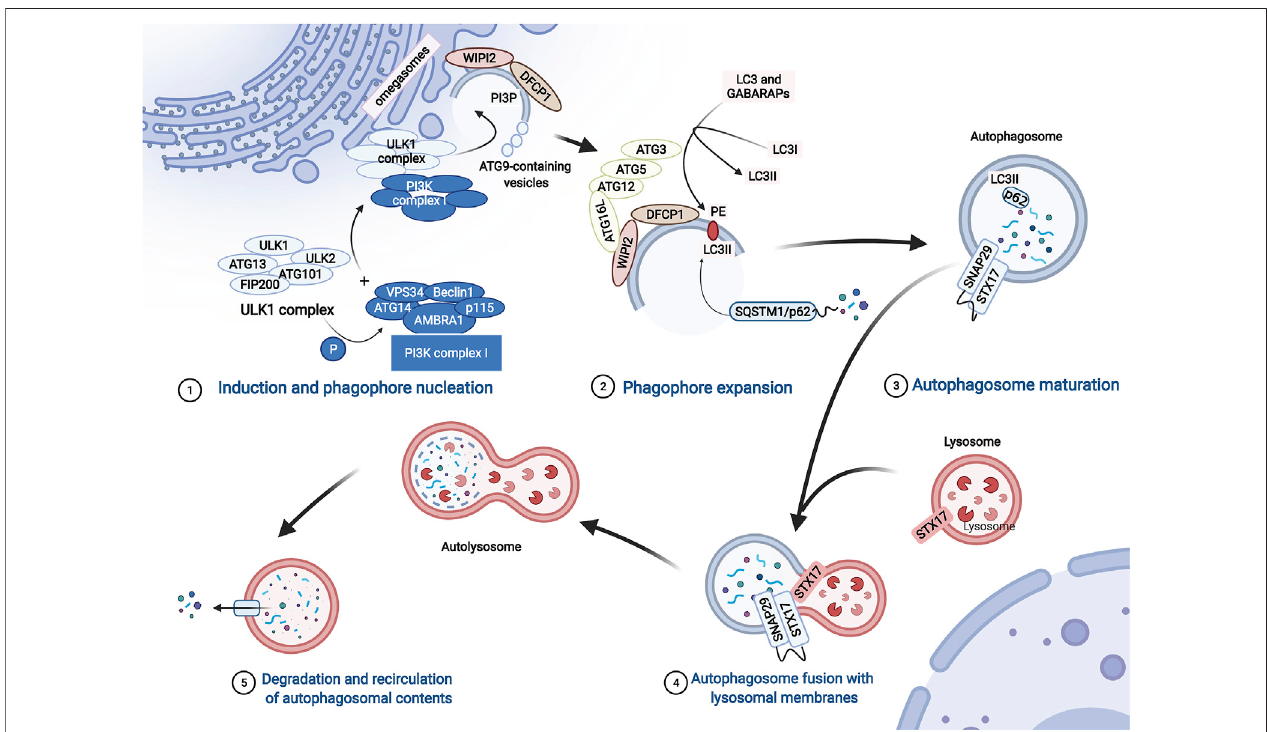
FIGURE 2 | The process of autophagy. The process of autophagy includes induction and phagophore nucleation, phagophore expansion, autophagosome maturation, autophagosome fusion with lysosomal membranes, degradation, and recirculation of autophagosomal contents. Induction and phagophore nucleation occurinthestructureknownasthe “ omegasome ” ontheendoplasmicreticulummembraneandaremainlymediatedbytheULK1complexandPI3KC3complexI.Local activated PI3P and recruited Atg9 provide the raw materials required for membrane formation. Then, the ATG12-ATG5-ATG16L1 complex is recruited to the membraneofthephagophore, enhancing theconversionofLC3andGABARAPs tomembrane-resident PE,promotingphagophoreexpansion.Duringtheformationof autophagosomes, p62 serves as a bridge connecting LC3 with the ubiquitinated substrate. Finally, the ATG12-ATG5 and ATG8/LC3 conjugation systems mediate the process by which the isolation membrane of the autophagosome forms a closed bilayer membrane structure and matures. Mediated by autophagosome-localized STX17, SNAP29, and lysosome-localized VAMP8, mature autophagosomes fuse with lysosomes to form autolysosomes, which degrade cytoplasmic contents with lysosomal